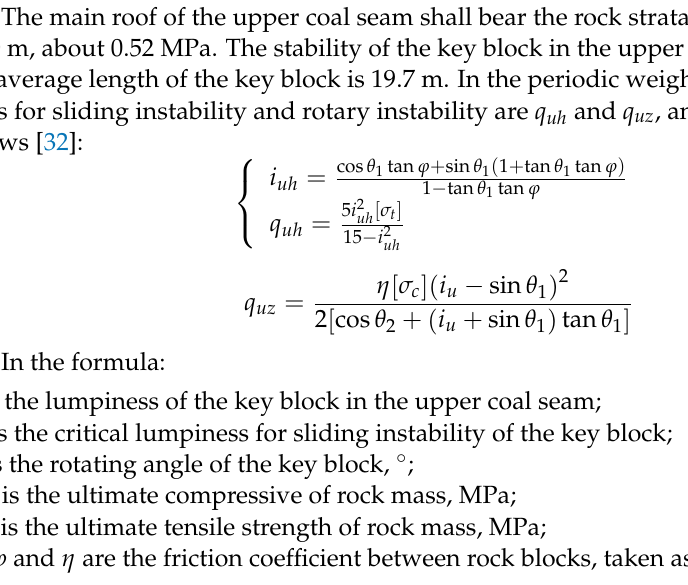
Figure 6. Interaction between key blocks of the upper main roof and lower main